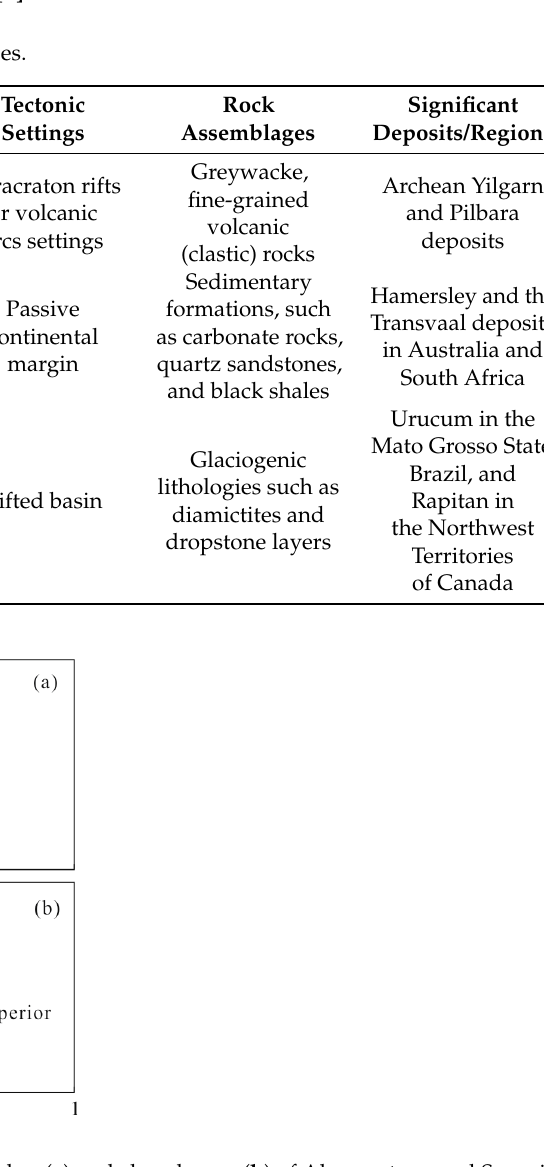
Figure 1. Comparison diagram in the number ( a ) and abundances ( b ) of Algoma-type and Superior- type BIFs through time (modi fi ed after Huston et al., 2004).